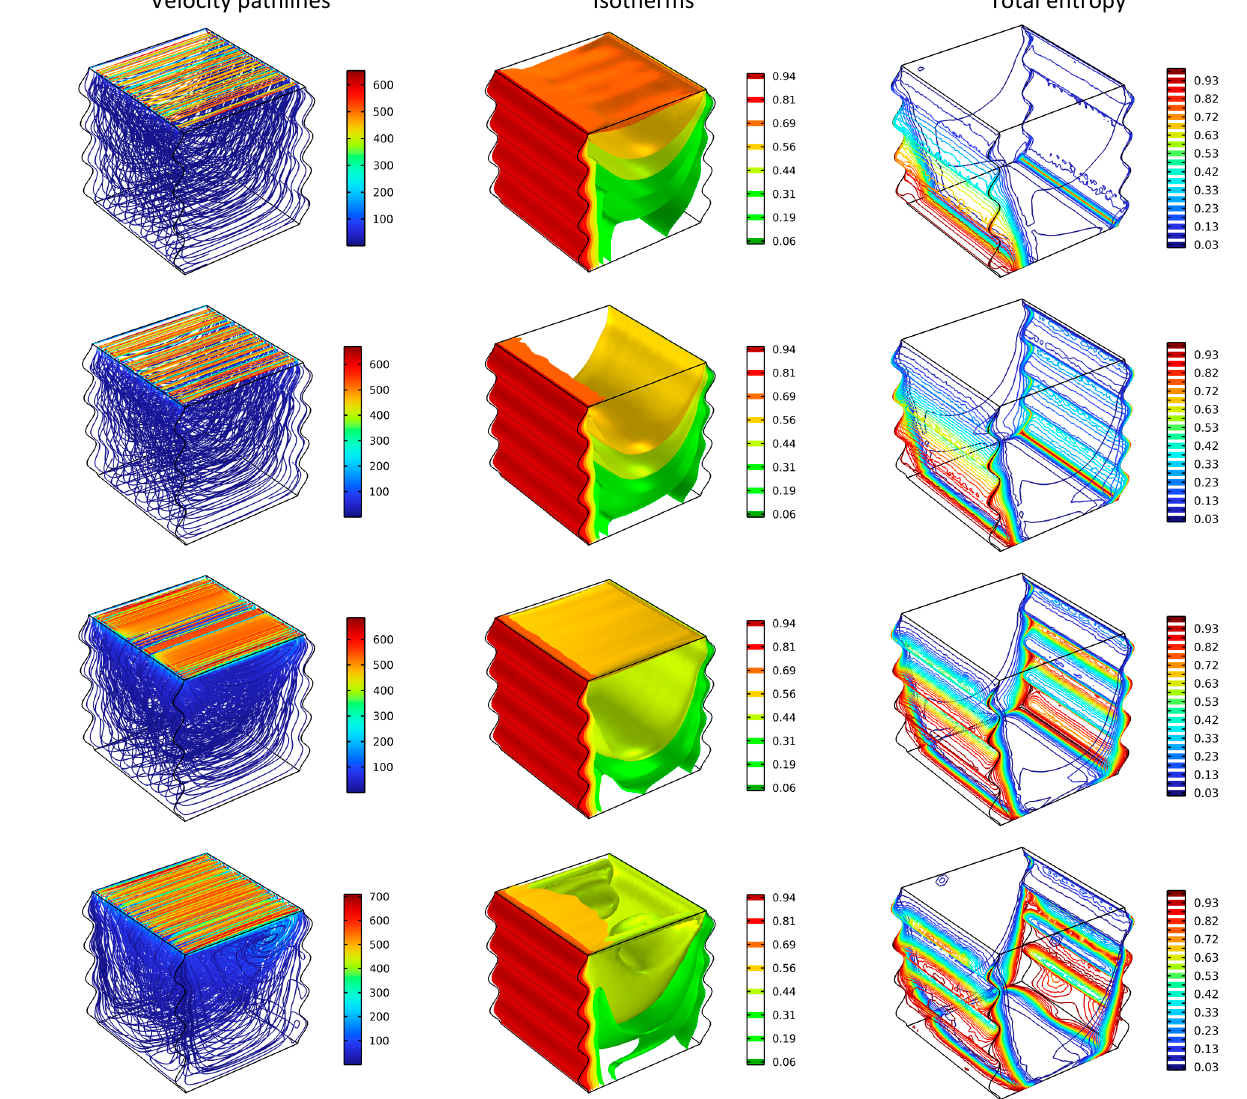
Figure 3. Distribution of the streamlines, isotherms, and total entropy for different Da for Ha = 0, ϕ = 0.04, and Re =